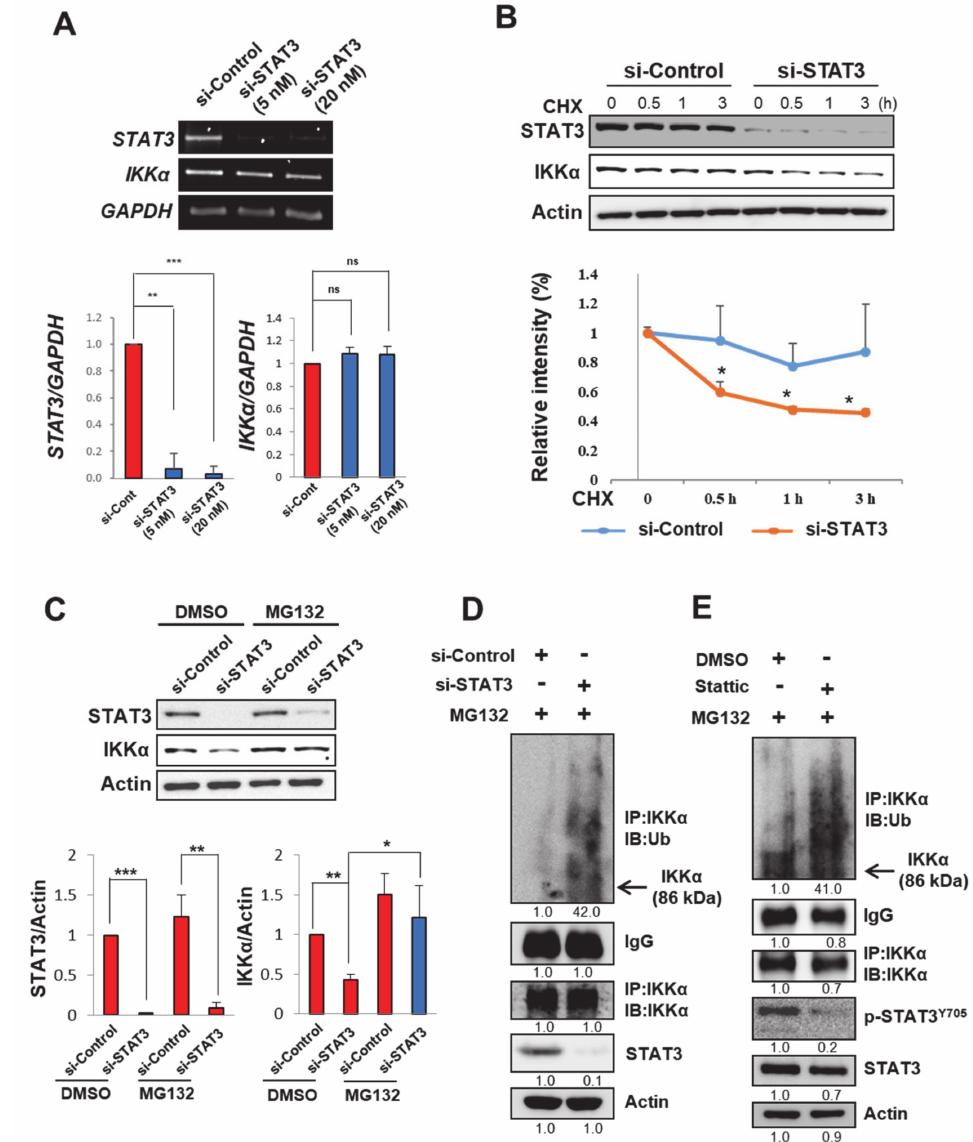
Figure 4. STAT3 protects IKK α from ubiquitin-dependent proteasomal degradation in H- Ras MCF- 10A cells. ( A ) RT-PCR analysis of STAT3 and IKK α mRNA expression in H- Ras MCF-10A cells transfected with si-Control or si-STAT3 (5 and 20 nM) for 48 h. The bar graphs show the